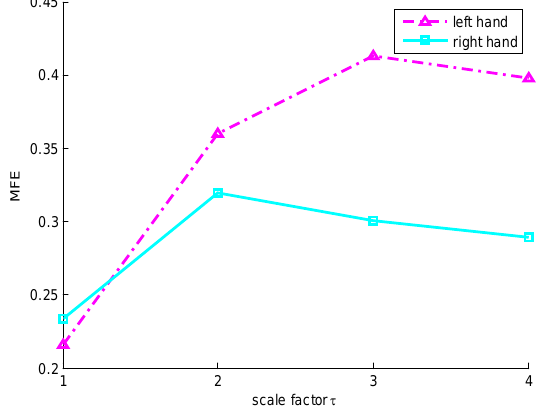
Figure 5. The MFE variation curves with scale factor τ . The pink dotted line and blue solid line represent the MFE of MI-EEG on channel C3 corresponding to imaginary left hand and right hand movement, respectively.